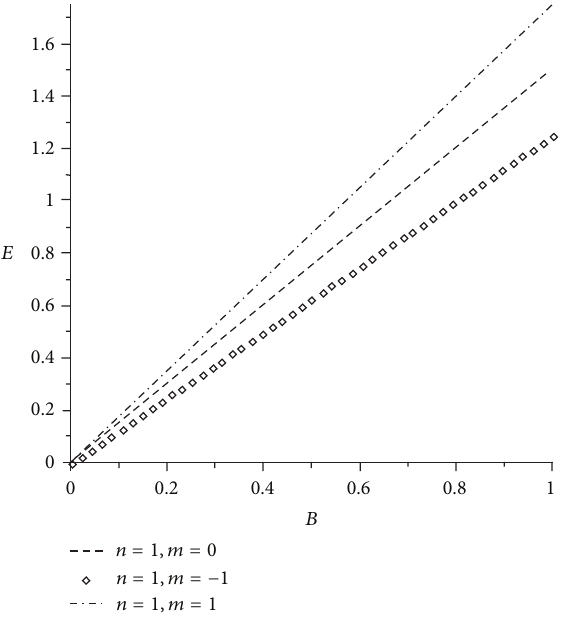
Figure 1: The energy eigenvalues versus 𝐵 (𝜃 = 0.000003, 𝜂 = 0.000001, 𝑀 = 1) .